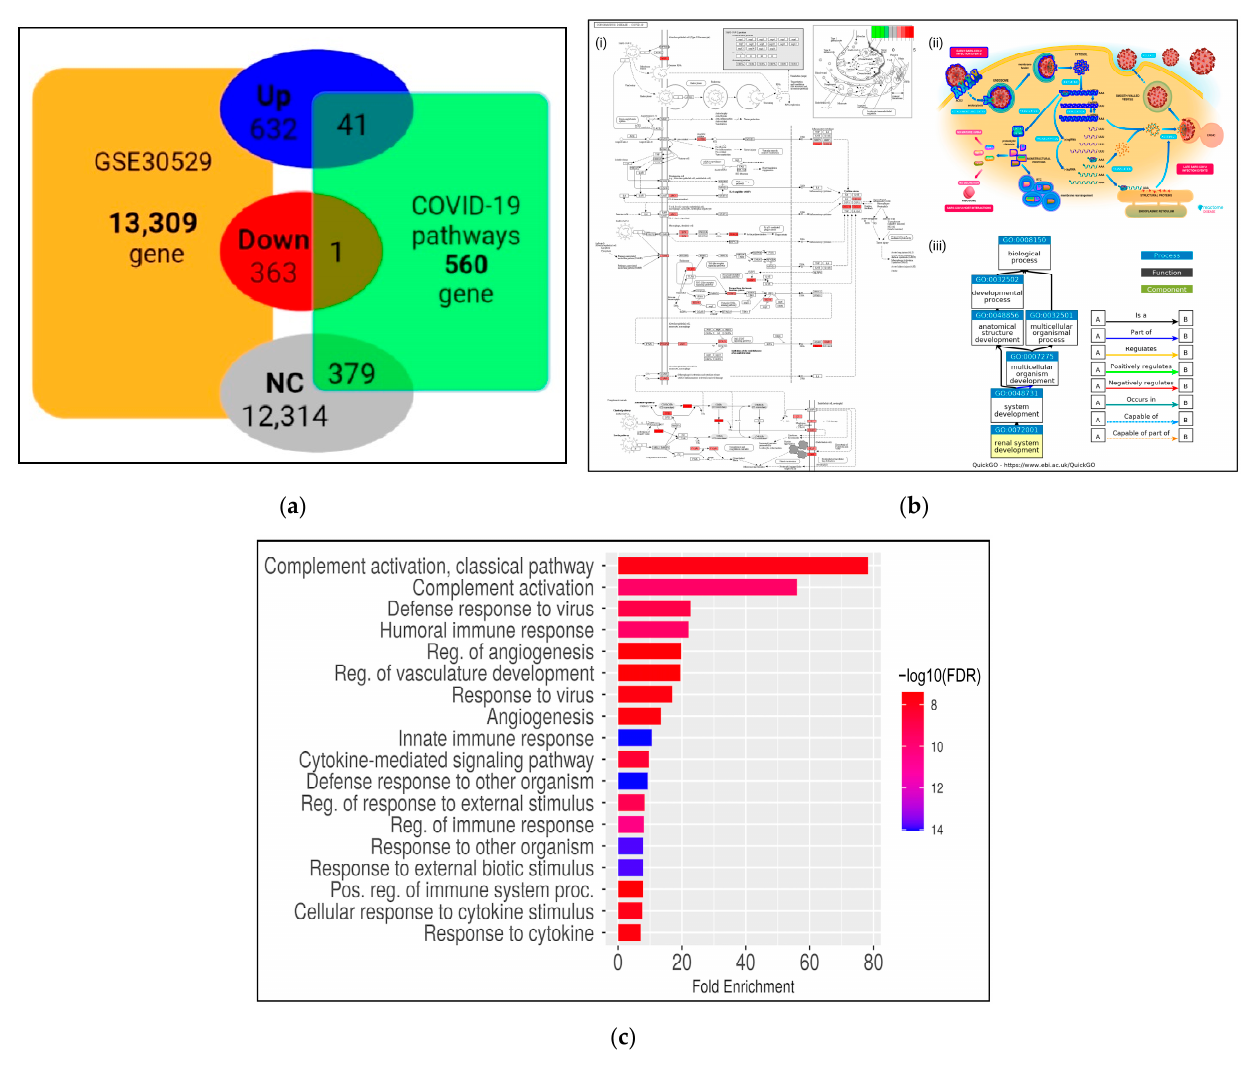
Figure 5. Identification of upregulated genes in DKD associated with COVID-19 pathways. ( a ) Diagram of overlapping DEGs among DKD and the COVID-19 pathways. The intersection of 41 genes in the COVID-19 pathway is shown. ( b ) (i) The KEGG pathway map hsa05171 is involved in Coronavirus disease-COVID-19. The rectangle in red color (light to dark), according to log Log2FC, indicates the upregulated DEGs overlapping DKD and COVID-19. (ii) the Reactome pathway R-hsa-9694516 and (iii) the GO term corresponding to renal system development. ( c ) Functional enrichment analysis of the shared genes among DKD and COVID-19 pathways. FDR is calculated based on a nominal p- value from the hypergeometric test. Fold Enrichment is defined as the percentage of DEGs belonging to a pathway divided by the corresponding percentage in the background. FDR reports how likely the Enrichment is by chance. Higher values are colored on a scale of red to blue. In the x -axis, Fold Enrichment indicates how drastically genes of a specific pathway are overrepresented.